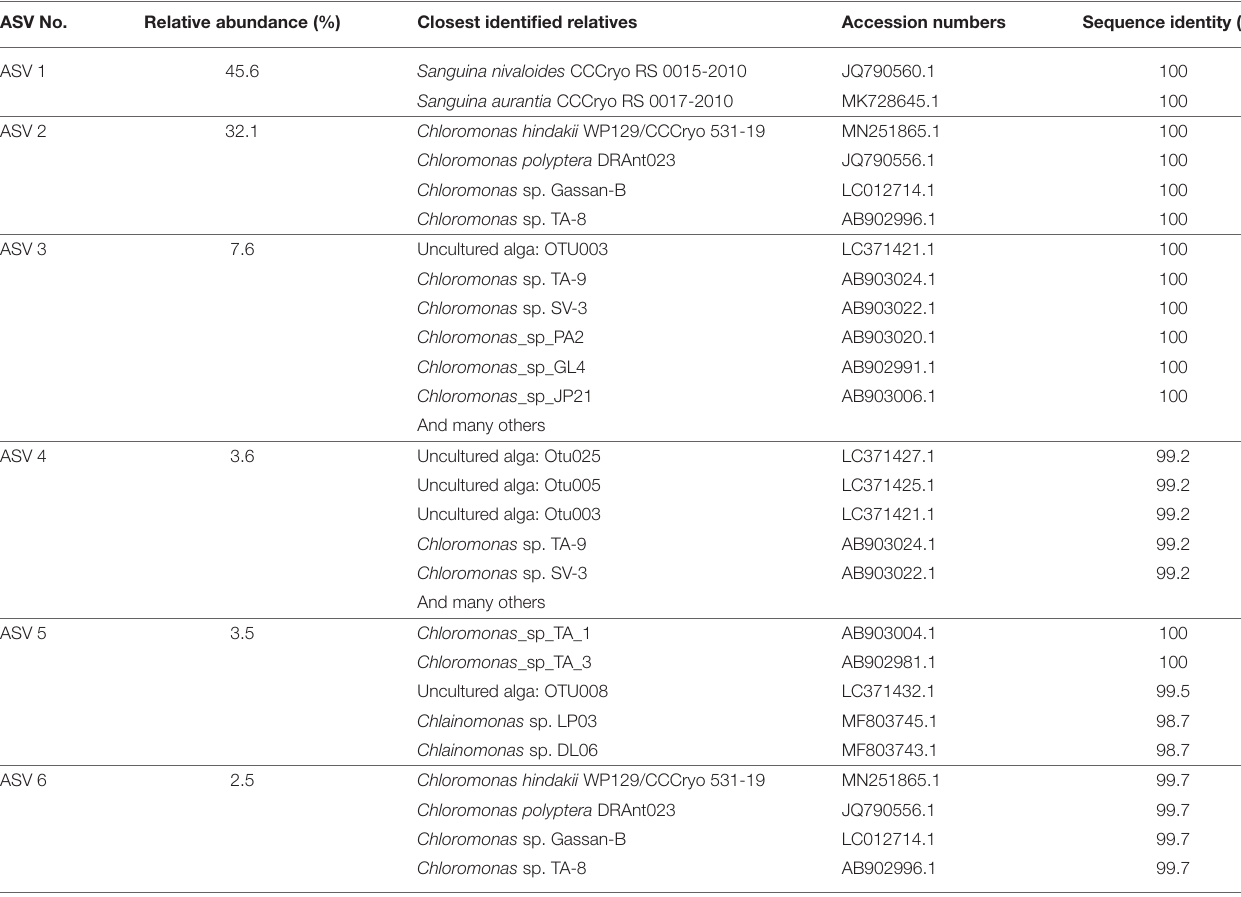
TABLE 3 | Top six ASVs (377-378 bp long) of 18S rRNA genes aligned and assigned to Chlorophyta in the samples, the closest relatives of the 18S rRNA genes that are based on the Nucleotide BLAST search in NCBI, and the sequence identity of 18S rRNA gene (%). ASV No.